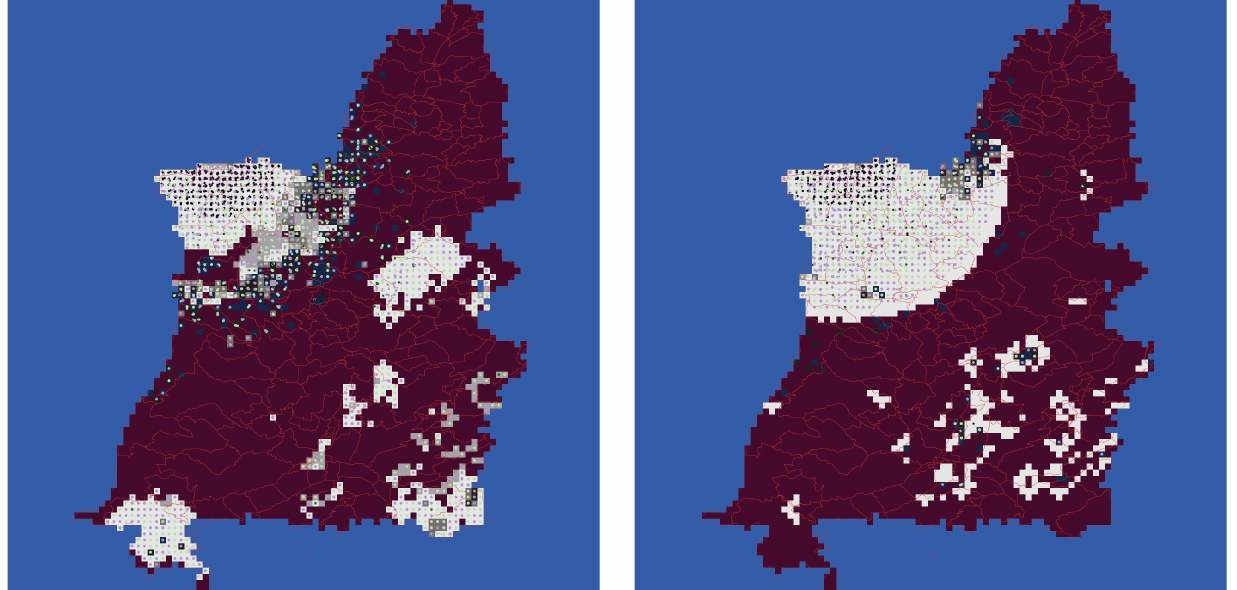
Figure 3. Beirut in 2010, a year prior to the Syrian refugee influx. Scenario with 2005 and 2006 events (left); same time point in the no‐events scenario